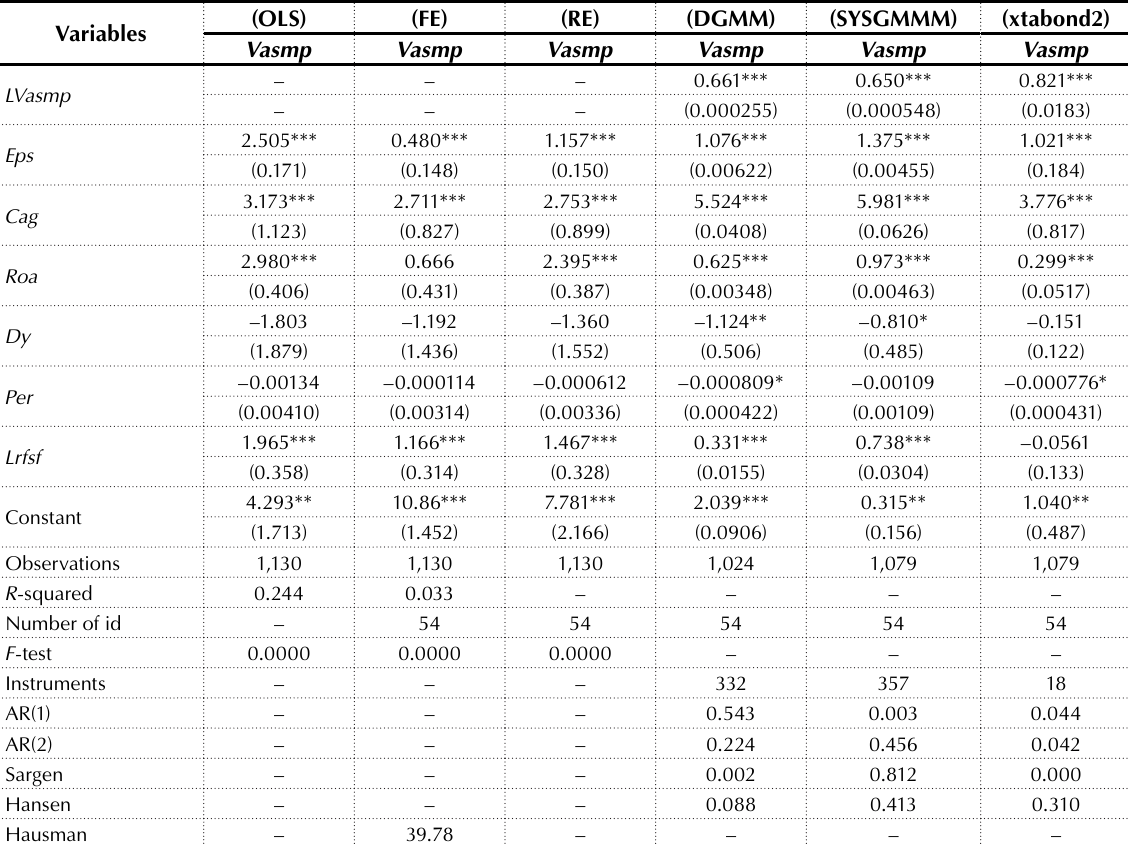
Source: Computed by the researcher using STATA